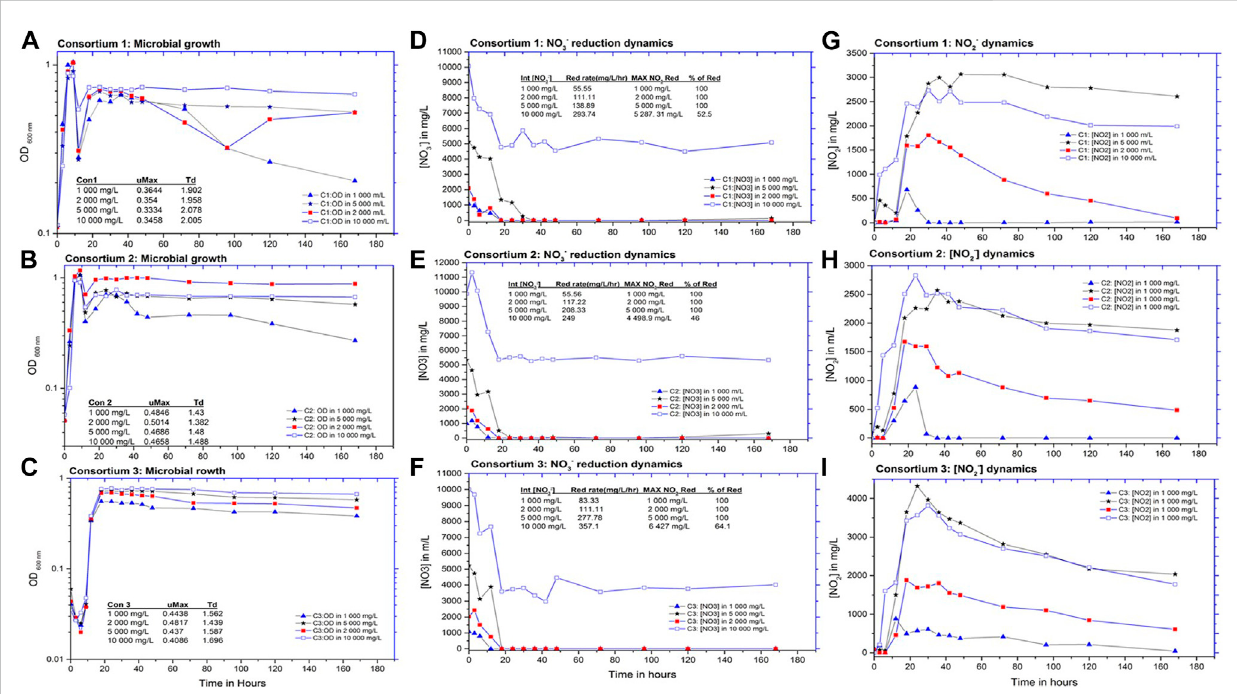
FIGURE 2 Microbial and denitri fi cation dynamics in increasing nitrate concentrations. (A – C) Microbial growth curves of C1, C2, and C3 cultures with 1,000, 2000, 5,000, and 10,000 mg/L of NO 3 . (D – F) Nitrate reduction pro fi les by C1, C2, and C3 consortia. (G – I) Nitrite reduction pro fi les of C1, C2, and C3